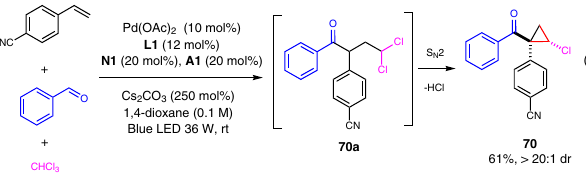
Fig. 3 | Synthesis of cholorcyclopropyl ketone 70. Alkylacylation using chloro- form as alkyl halide gave chloorocyclopropyl ketone as the fi nal product.